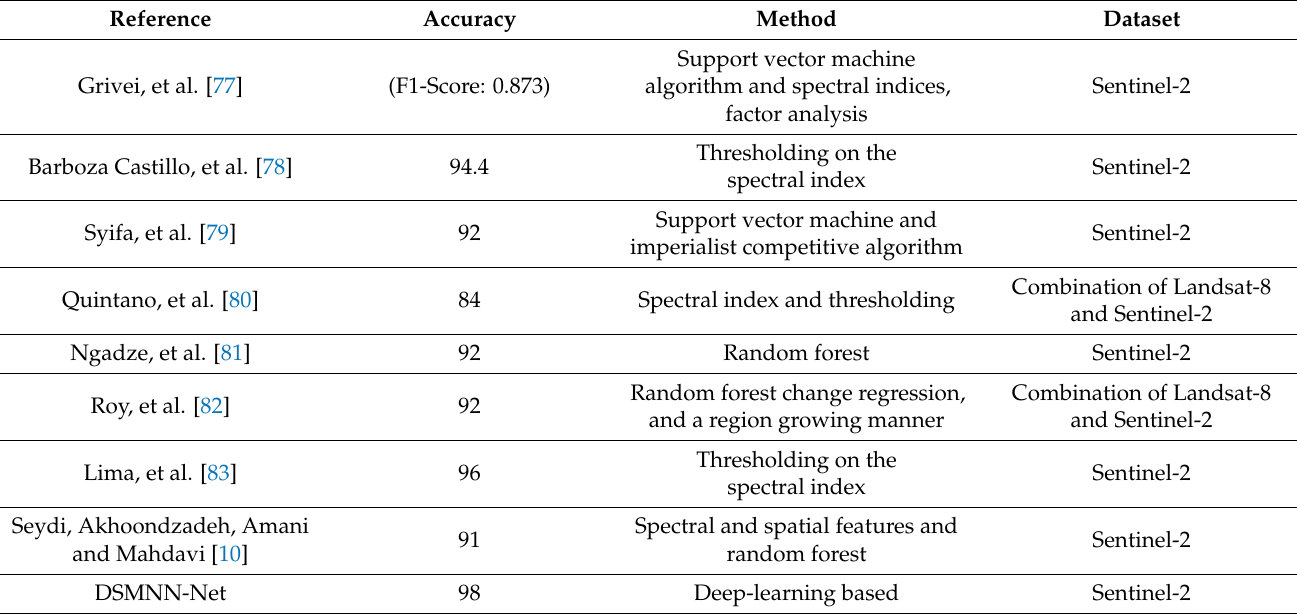
Table 6. Comparison of performance of the DSMNN-Net with other burned area mapping